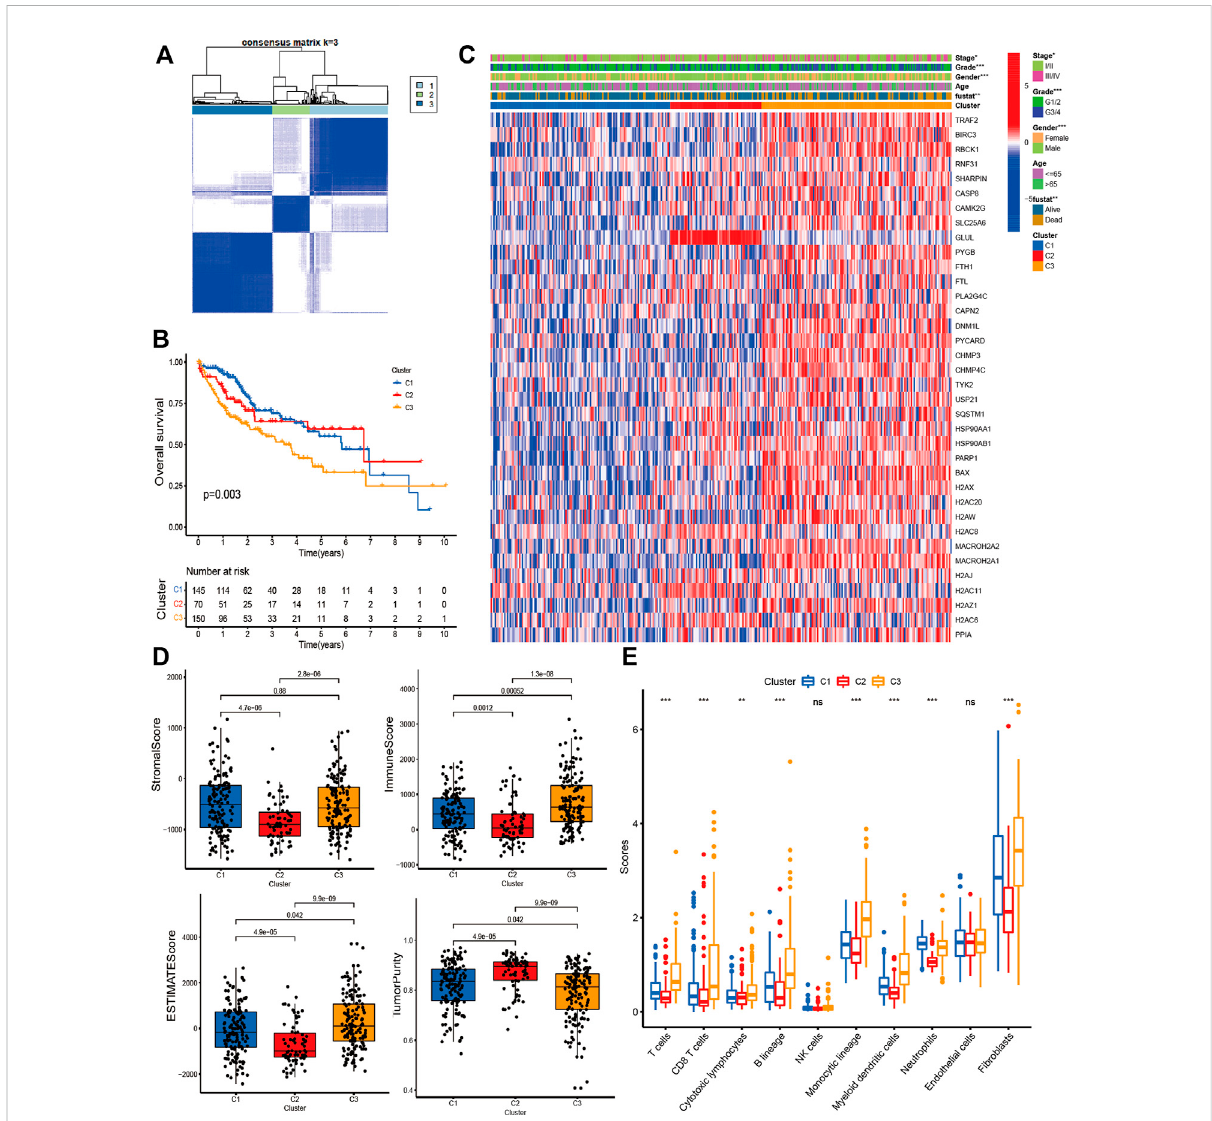
FIGURE 3 ConsensusClusteringanalysis. (A) Consensusmatrixwhenthenumberofclusters(k)=3; (B) Kaplan-Meiercurvesshowthesurvivaldifferences between subtypes; (C) The heatmap shows the expression of NRGs and clinicopathological features between subtypes; (D) Bar plot shows the Stromal score, Immune score, ESTIMATE score, and Tumor purity between subtypes; (E) Bar plot shows the immune in fl ation between